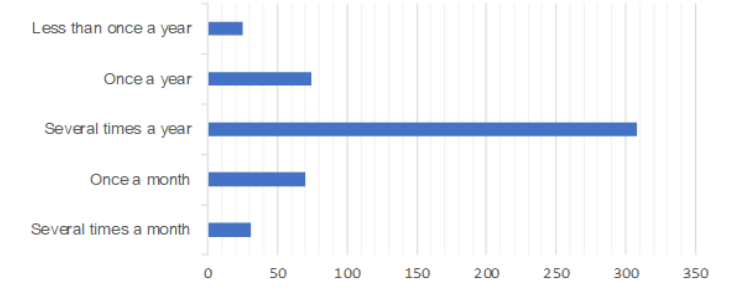
Figure 2. Assessment of the importance of different children’s skills by educators and assistant educators